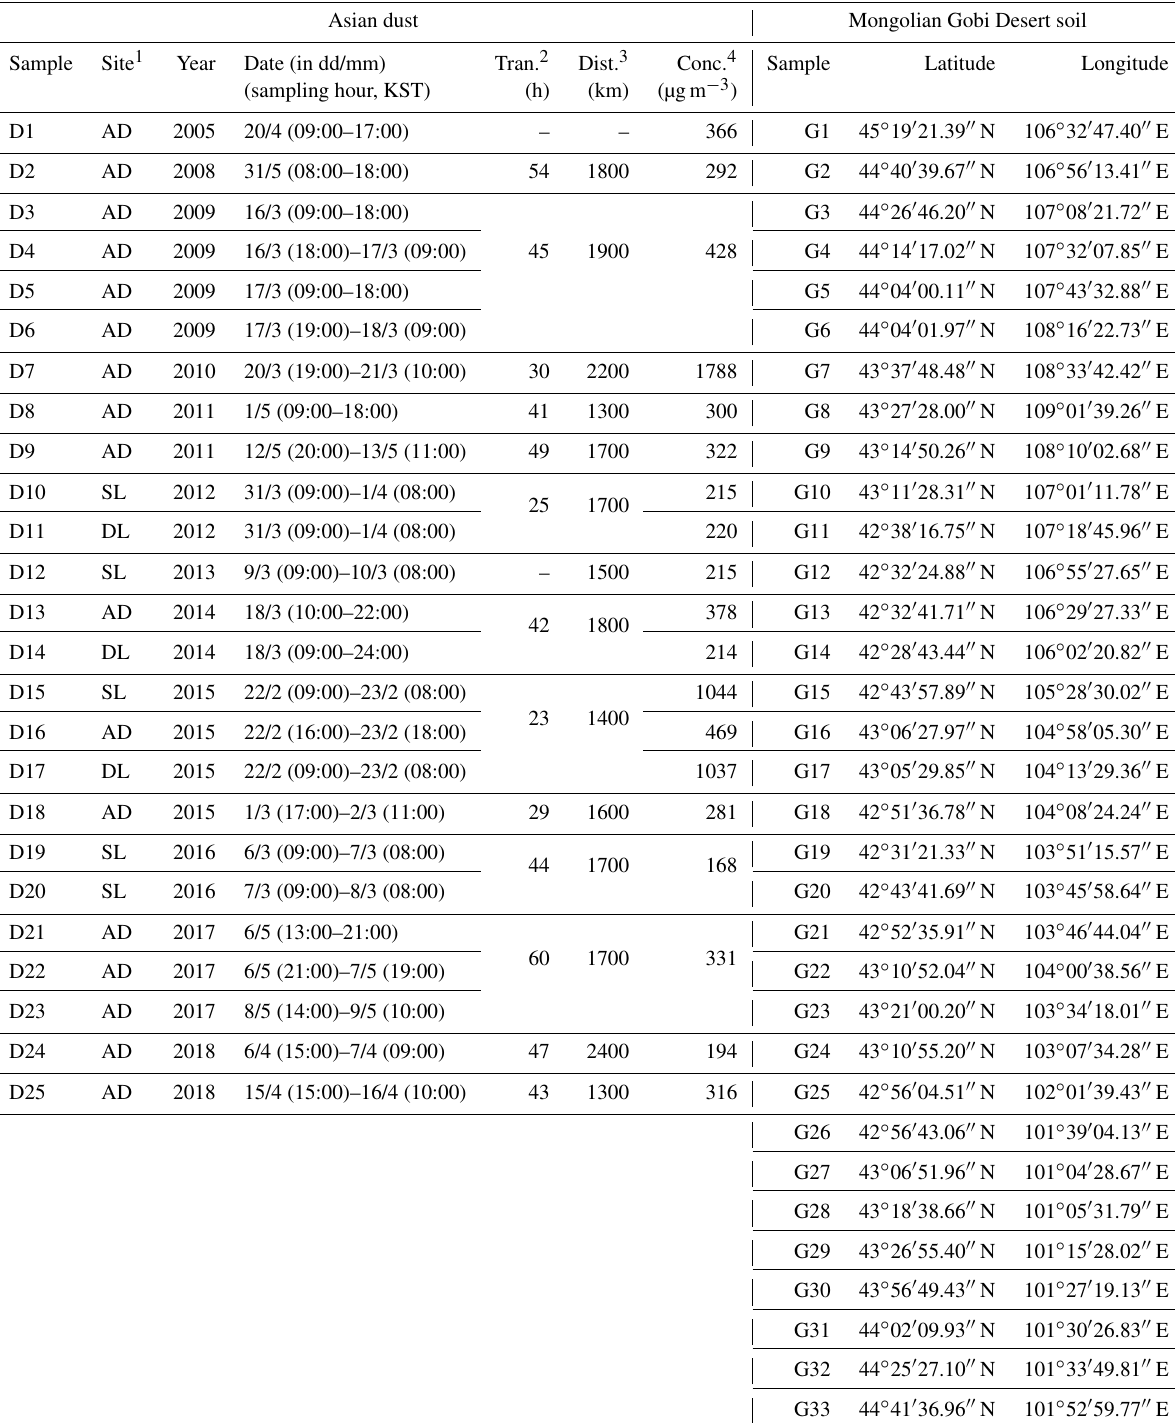
Table 1. List of Asian dust sampled in Korea and desert soils from the Mongolian Gobi Desert. (All time references in the table refer to Korea standard time, KST.)